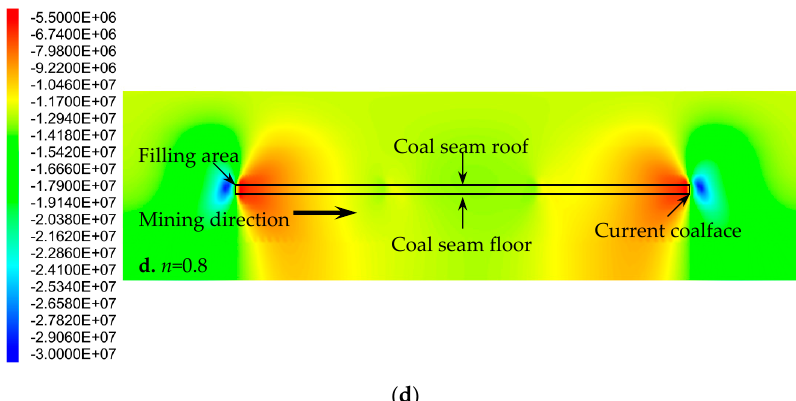
Figure 15. The Z-direction stress field of the strata (Y-Z profile at X of 80 m) when the goaf was filled with cemented rockfill with different granule gradations at a mining distance of 120 m. n = 0.2 ( a ); n = 0.4 ( b ); n = 0.6 ( c ); and, n = 0.8 ( d ).